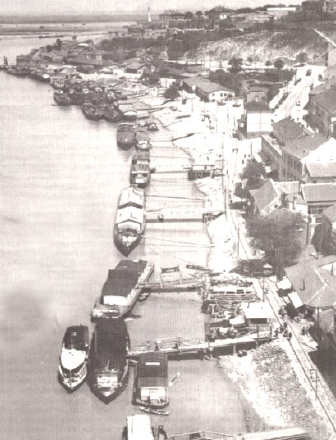
Figure 3. Old Belgrade by the river Sava(Photo of Belgrade 1920, according to: `Politika` newspaper 13.2.2013.)